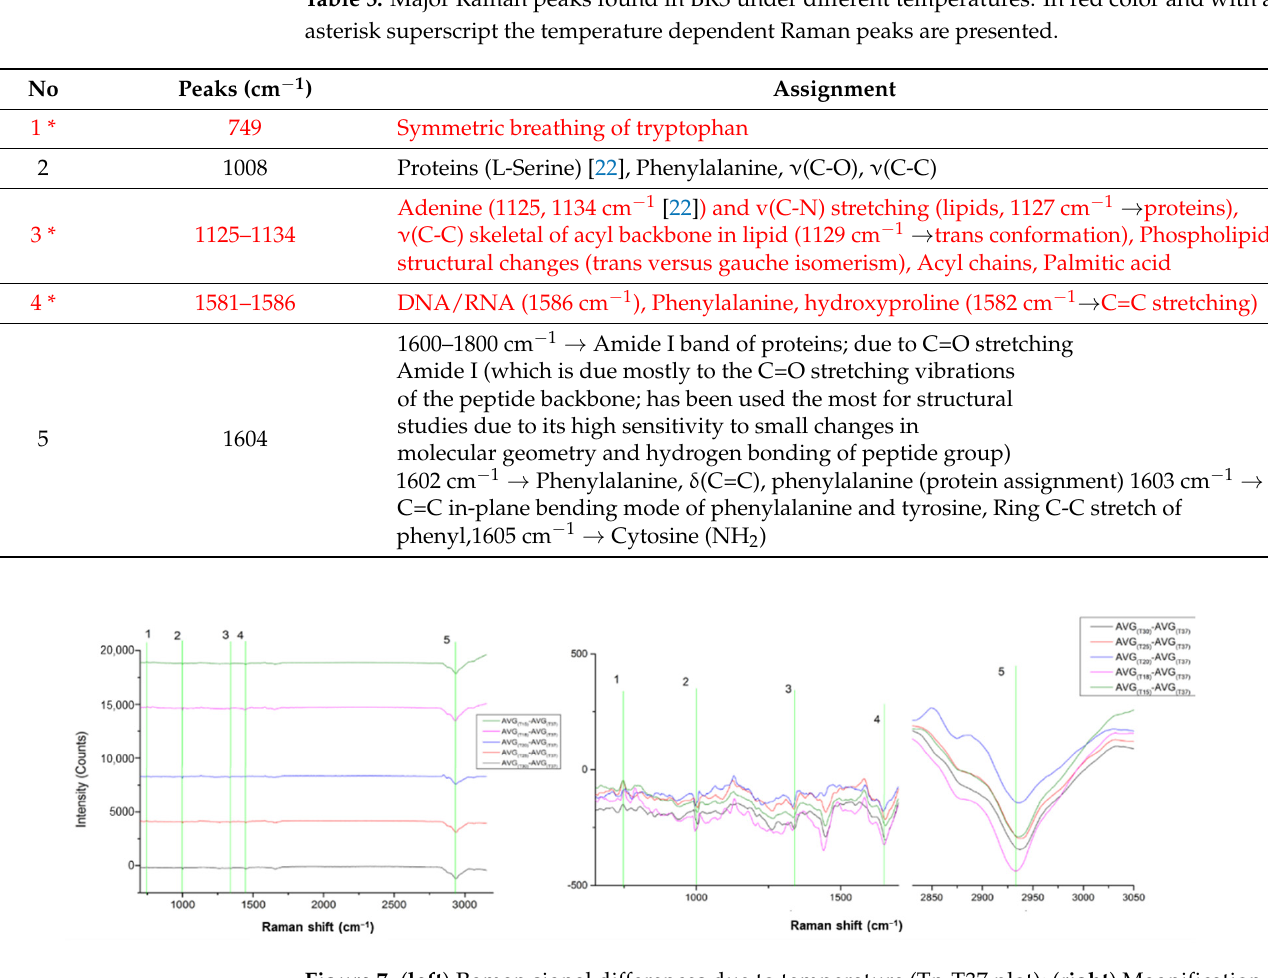
Figure 7. ( left ) Raman signal differences due to temperature (Tn-T37 plot); ( right ) Magnification of Raman signal differences.